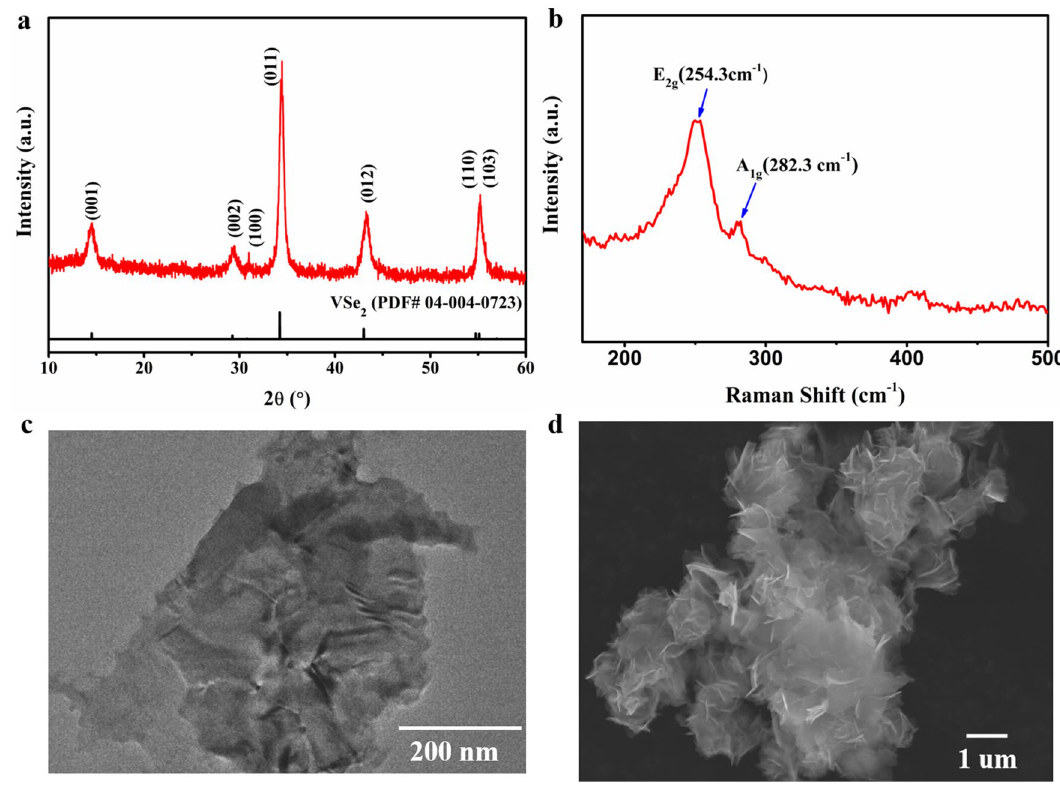
Figure 1. Characterization of the synthesized VSe 2 NSs. ( a ) X-ray diffraction. ( b ) Raman spectrum. ( c ) TEM image of a nanosheet. ( d ) SEM image of a nanosheet agglomerate.